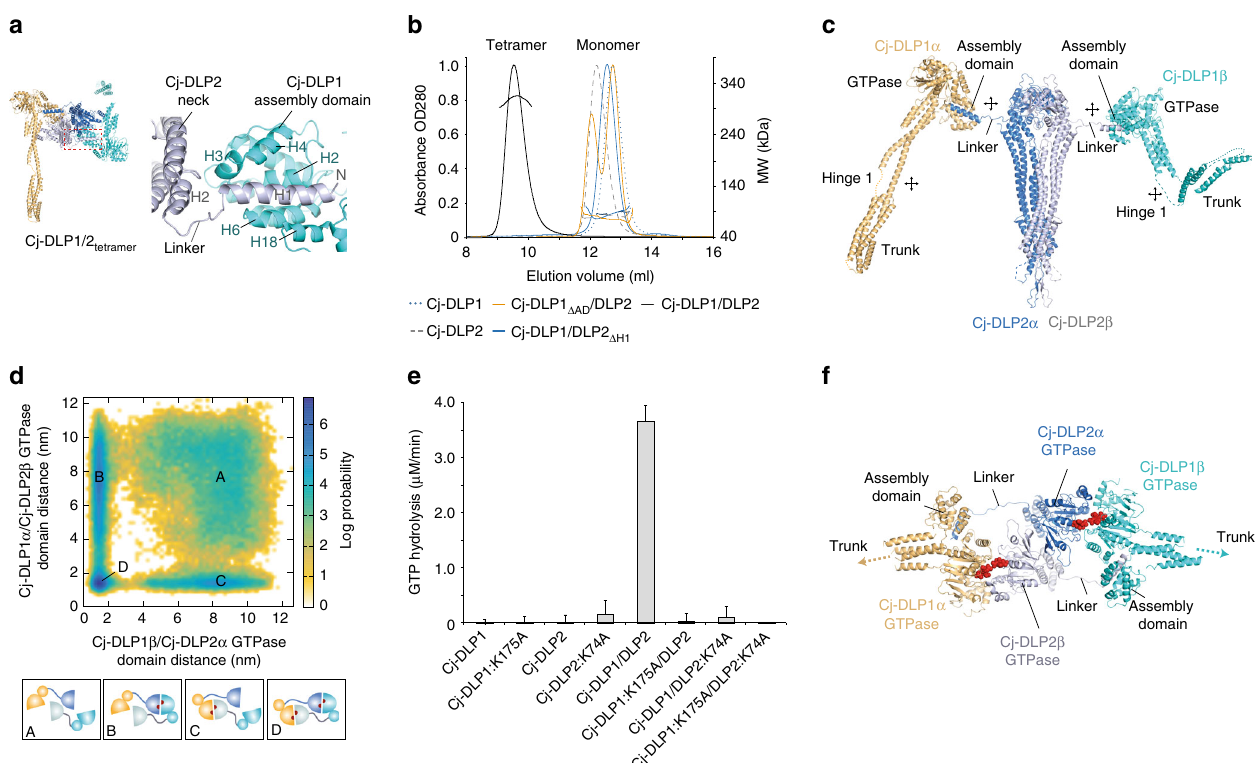
Fig. 5 Cj-DLP1/2 tetramer oligomerisation and catalysis. a Cartoon showing Cj-DLP1 and Cj-DLP2 heterodimerisation mechanism. The N-terminal Helix 1 of Cj-DLP2 inserts into a groove within Cj-DLP1 AD . Right panel shows zoom of left panel box. b SEC-MALS shows that truncation of Cj-DLP1 AD or Cj-DLP2 H1 abolishes tetramer formation. c , Schematic model of Cj-DLP1/2 tetramer when in a solution state, rather than crystalline. The position of each Cj-DLP1 subunit relative to Cj-DLP2 has been chosen arbitrarily to highlight the 9 amino acid random coil linker. Crossed arrows indicate regions of high fl exibility. d Histogram showing a structure-based molecular dynamics (MD) simulation of the Cj-DLP1/2 tetramer in c . The Cj-DLP2 linker is of suf fi cient length for GTPase heterodimerisation to occur. The two G-domain pairs transition between apo state in A, a mix of apo state and G-dimer in B and C, or G-dimer in D. e GTPase assays show that Cj-DLP1/2 tetramer exhibits signi fi cant assembly stimulated turnover which is a known catalytic consequence of G-dimerisation. 1 or 2 µ M protein concentration was used for tetrameric or monomeric species, respectively. Data represent mean ± standard deviation from 2 independent experiments. f Model of Cj-DLP1/2 tetramer G-dimerisation based on data presented in d and e . Note that the geometry of the linker allows no other combination of G-dimerisation to occur within Cj-DLP1/2 tetramer in the observed suf fi cient to allow G-dimer formation between Cj-DLP1 and Cj- DLP2 (Fig. 5d, Supplementary Fig. 4b and Supplementary Movie 1). This in silico model is supported by in vitro GTPase activity assays. While individual Cj-DLP1 and Cj-DLP2 proteins show negligible GTP hydrolysis, Cj-DLP1/2 tetramer at 1 µM con- centration shows signi fi cant assembly-stimulated activity with a maximal observed hydrolysis rate of 3.6 µM/min (Fig. 5e).